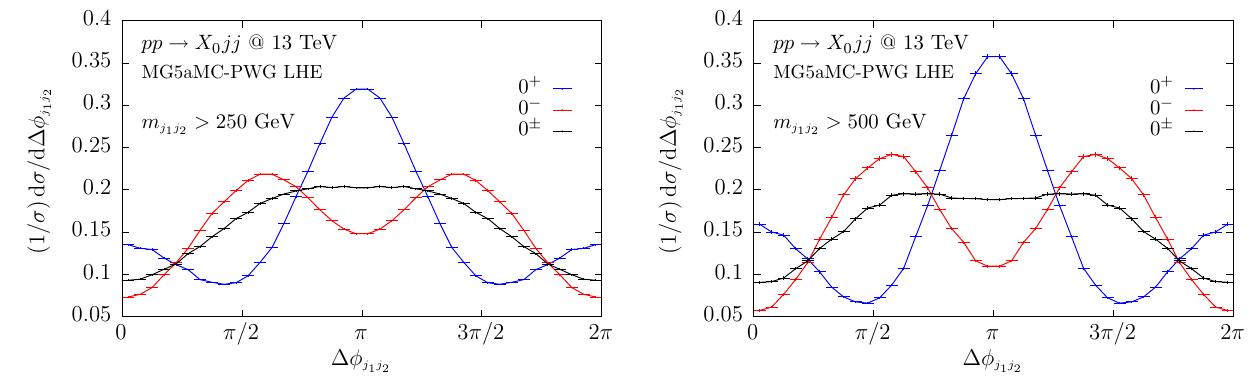
Fig. 7 Normalised differential cross section as a function of the azimuthal separation of the two leading jets (see Eq. (3.10)), for the three CP scenarios. On the left panel, a cut of 250 GeV is imposed on the dijet mass, while on the right panel a cut of 500 GeV is applied. The colour code is the same as in Fig. 1